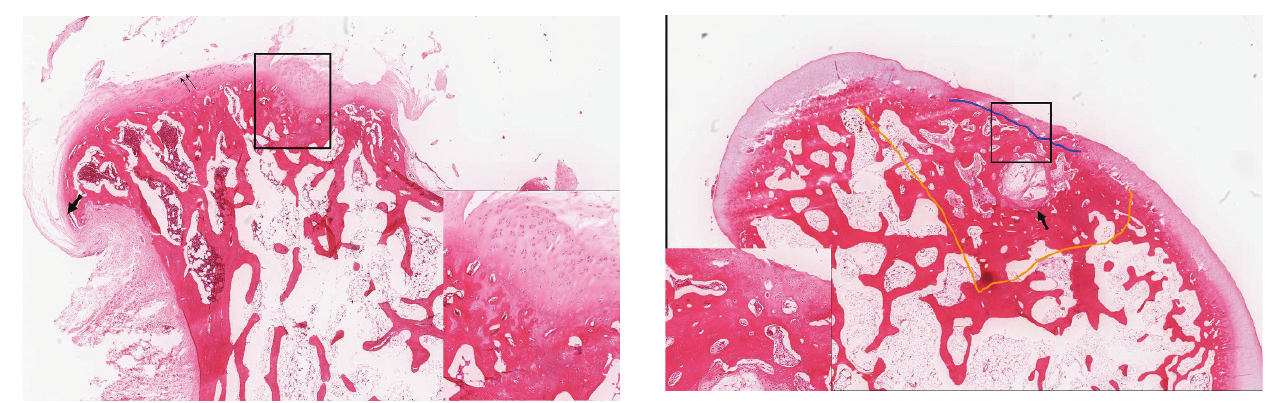
Figure 3 - Group A specimen. Image shows focal thickening of the articular cartilage and the cortical bone (insert) with a deformed articular surface. Fissuring (double arrows) and osteophytes (arrow) are shown (H & E stain).